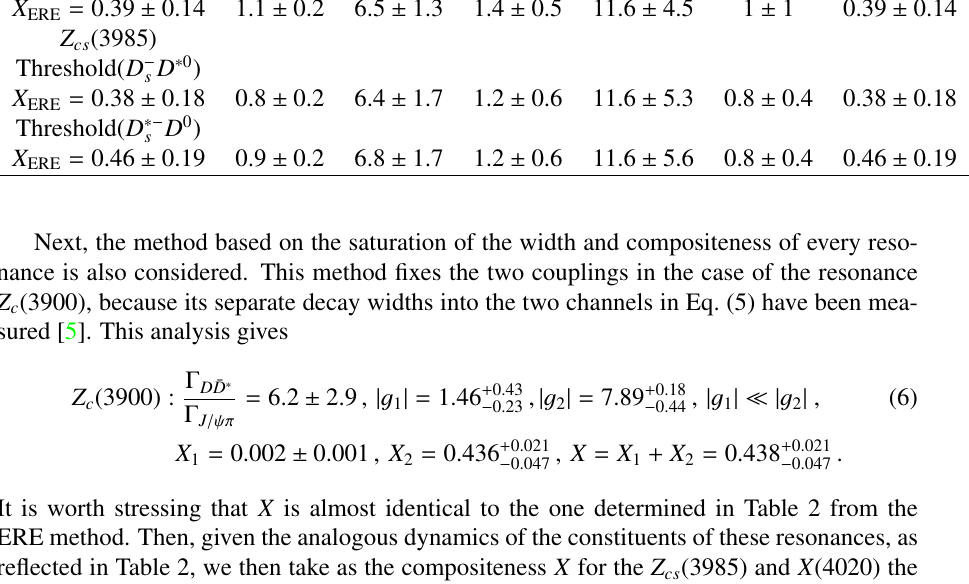
by taking either the threshold of D −